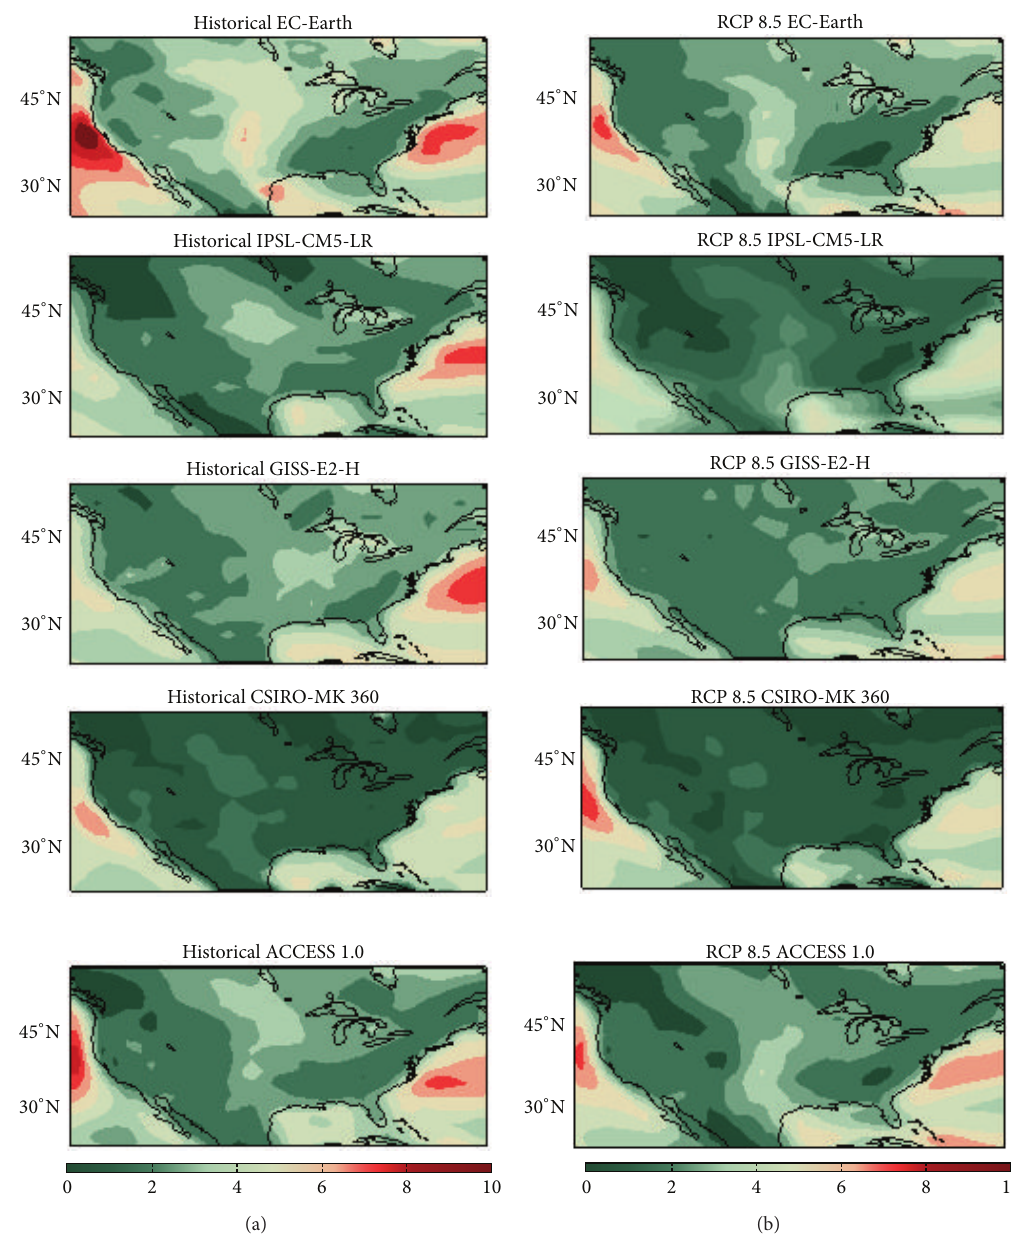
Figure 2: Similar to Figure 1 but for the climatology for summer (JJA). (a) and (b) are the historical and RCP 8.5